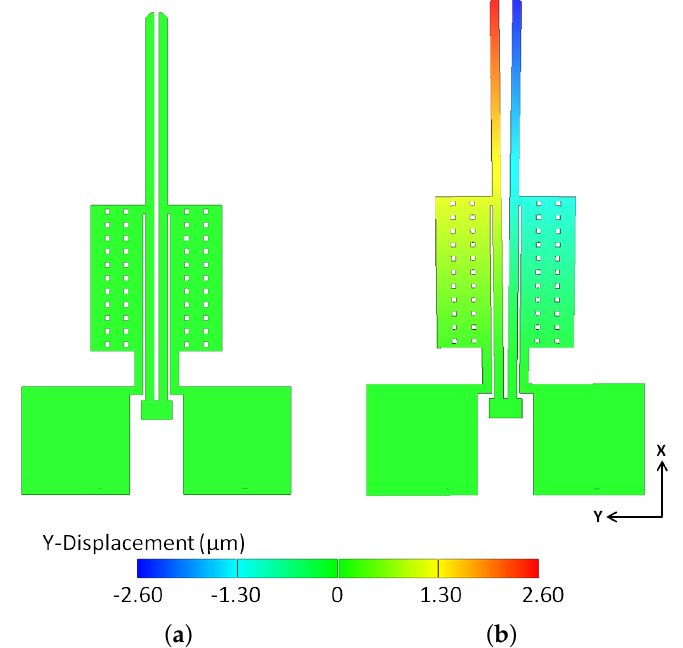
Figure 14. Simulated steady-state lateral displacement profile of the polysilicon electrothermal microgripper: at no applied potential ( a ), and when each arm is subjected to an applied potential of 3 V ( b ). The gap opening in the closed position is 5 µ m ( a ). At 3 V, each arm moves laterally by 2.6 µ m such that the total gap opening at 3 V is 10.2 µ m ( b ).